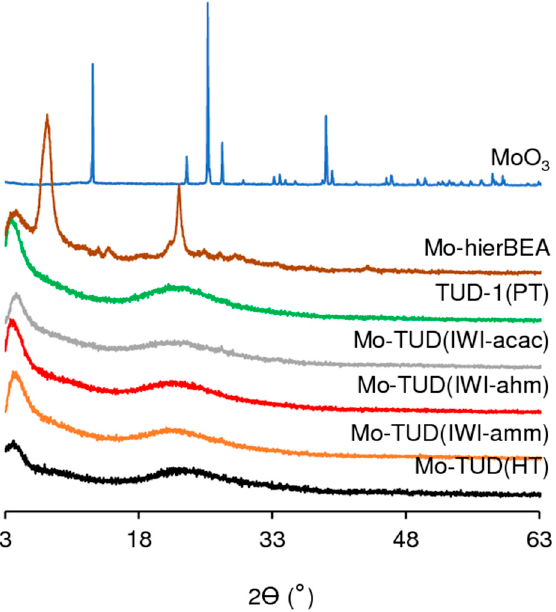
Figure 2. PXRD patterns of the prepared materials and, for comparison, bulk MoO 3 .